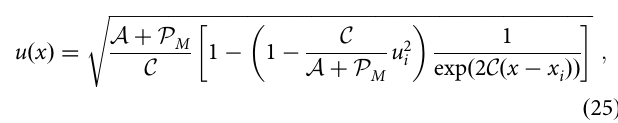
Fig. 4. Typical parameter values for the results presented in Fig. 4 are: A ¼ 4 : 2271 ; P respectively.